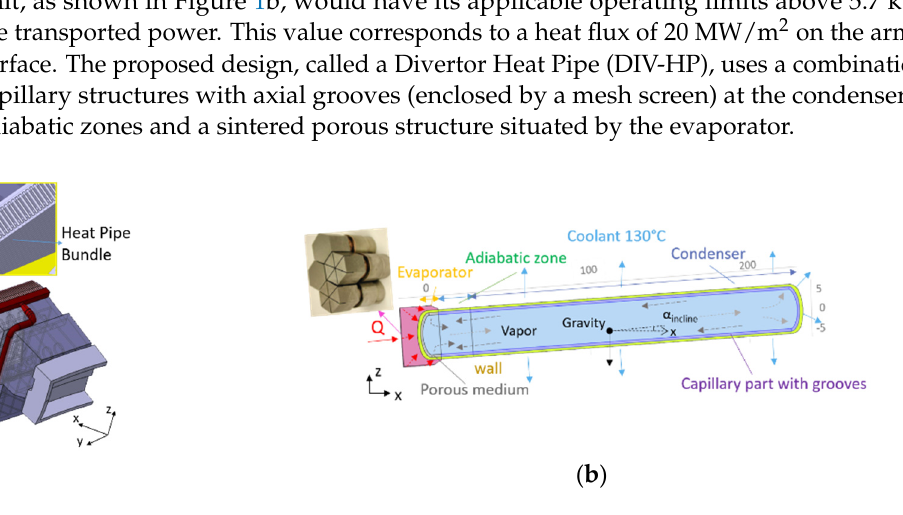
Figure 1 . EU-DEMO divertor concept featuring a heat-pipe-based target from [1]: ( a ) target concept and its integration with the divertor cassette; ( b ) DIV-HP heat pipe unit dimensioned with proposed tungsten armor.